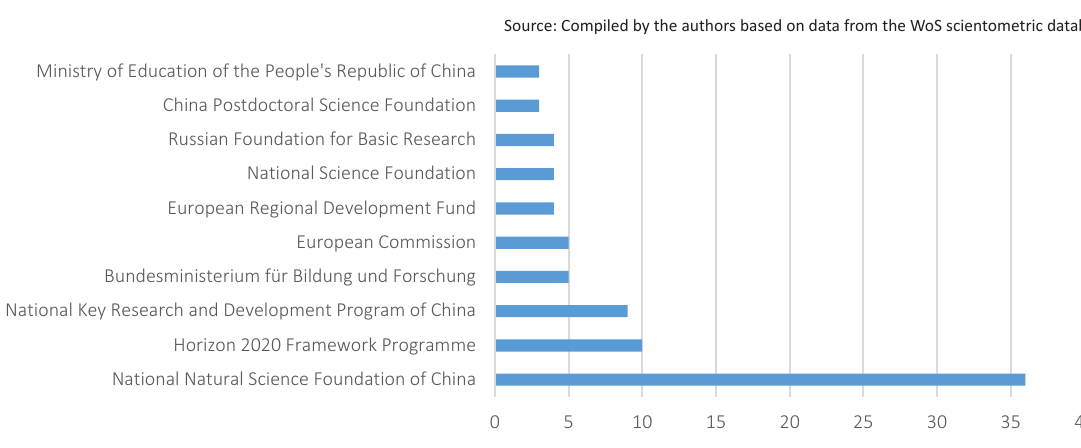
Figure 10. Organizations funding research in the WoS